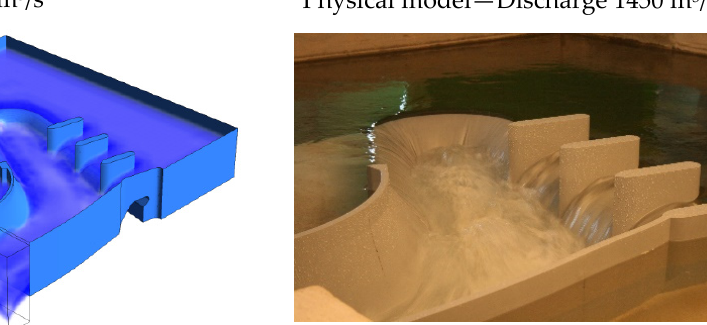
Figure 10. Comparison among the 2003 flow event ( a ) with a picture of the real event, ( b ) the physical model output and ( c ) the result of the numerical simulation. Though the air entrainment at the prototype scale appears more evident, the physical and numerical models present similar flow features.